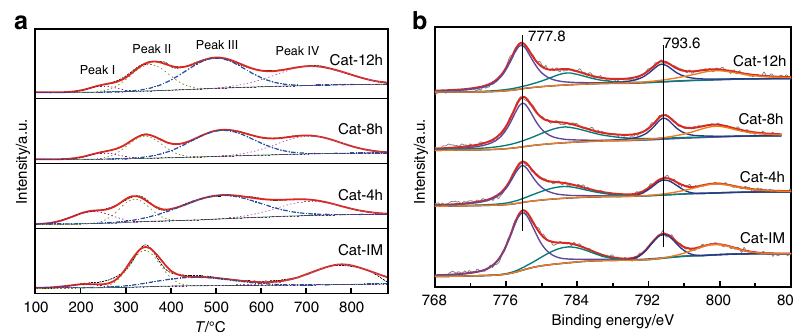
Fig. 4 Embedment of Co species. a H 2 -TPR pro fi les of the catalysts. b In situ XPS spectra of the catalysts at Co 2 p core levels